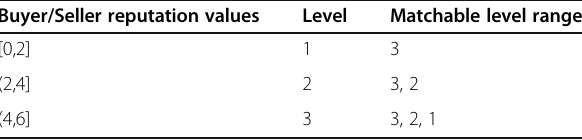
Table 2 Market segmentation machine based on